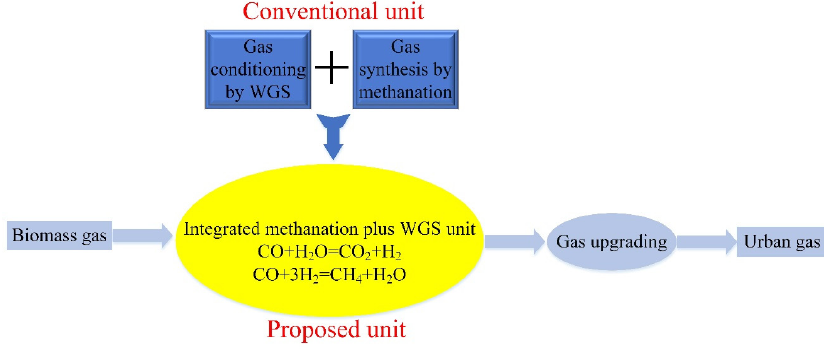
Figure 1. General scheme of the process chain from biomass gas to urban gas. WGS, water gas shift.